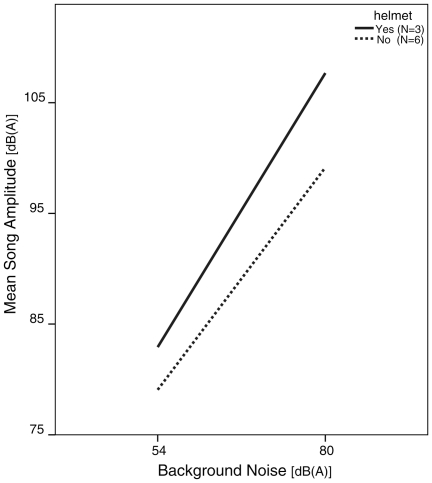
Mean increase in song amplitude between the lowest (ambient room noise) and highest background noise conditions.Solid line is the change in mean song amplitude for three birds recorded inside respirometry helmets. Dashed line is the change in mean amplitude for six unhelmeted birds recorded in small plastic chambers with the same microphones as those used in respirometry helmets. For each individual, the microphone was positioned in a fixed location relative to the bird's head. In both the chambers and the helmets, the microphones were positioned very close (less than 2.5 cm) to the source, but the microphones inside the helmets were typically nearer to the bird's head than were the chamber microphones.